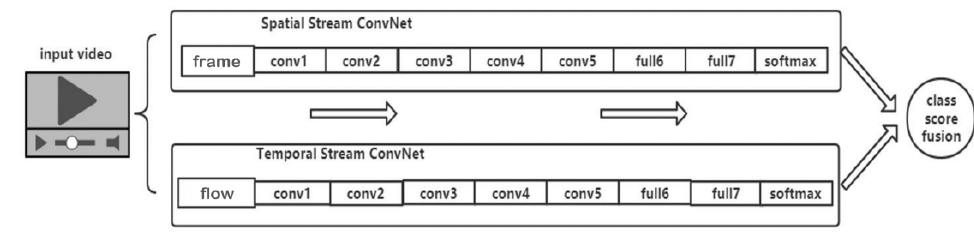
Figure 5. Two-stream convolutional network